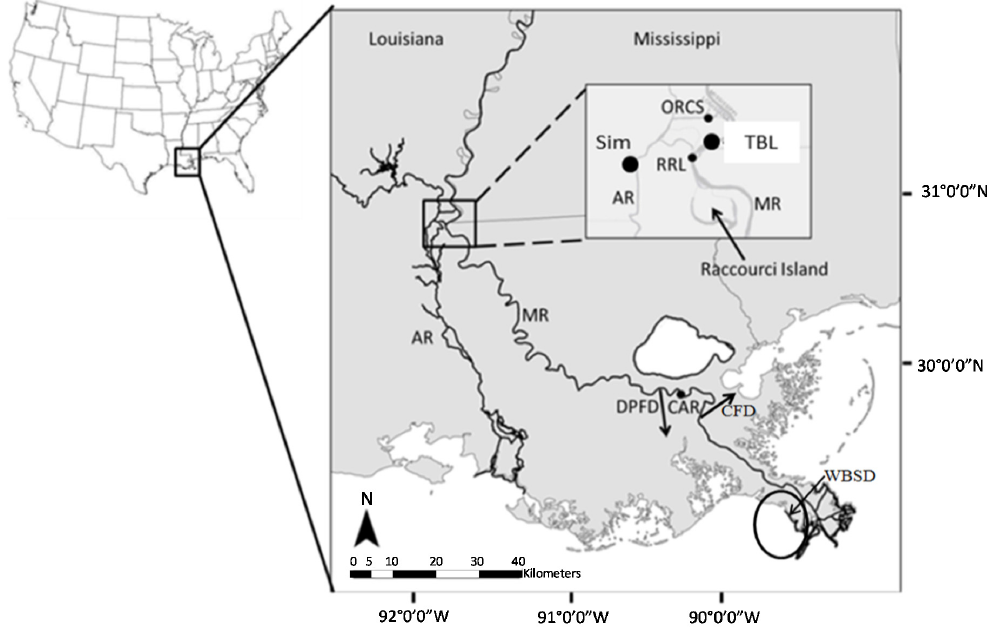
Figure 1. Study area map (modified from Rosen and Xu [21]) showing the location of the LmMR at Tarbert Landing (TBL) (USGS Station ID 07295100 and USACE Gage ID 01100). MR and AR denote